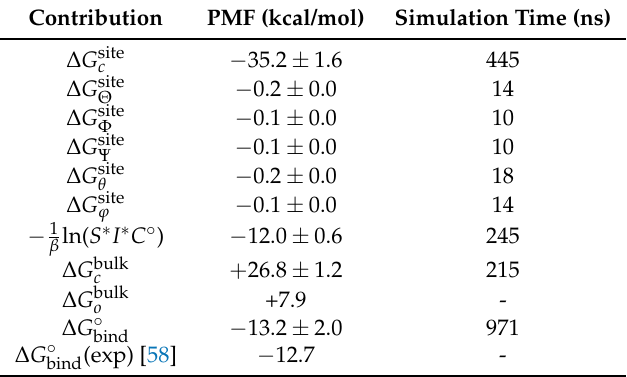
Table 1. Contributions to the standard binding free energy for netropsin associated with